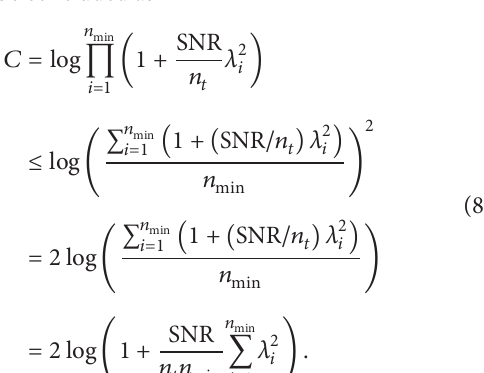
F 3: Circle scatterer model setup.